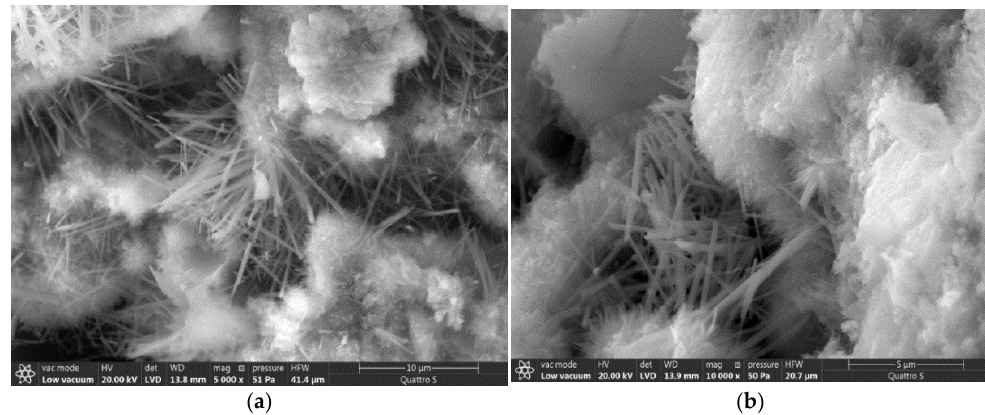
Figure 4. The microstructure of the matrix modified with 7% of carbon nanotubes at various magnifications: 5 000– ( a ), 10 000– ( b ).